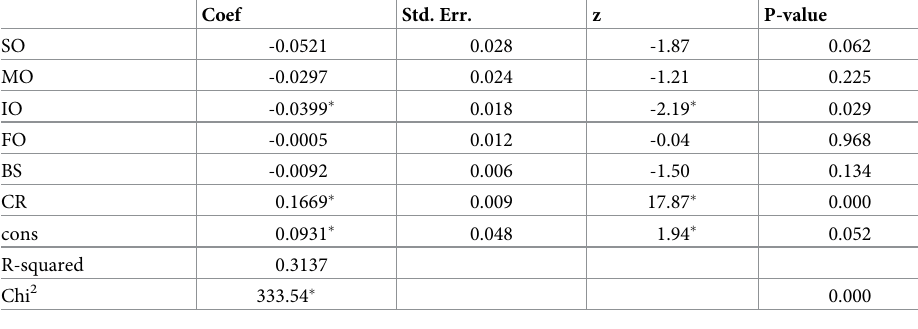
Dependent variable: ROA, � indicates statistical significance at